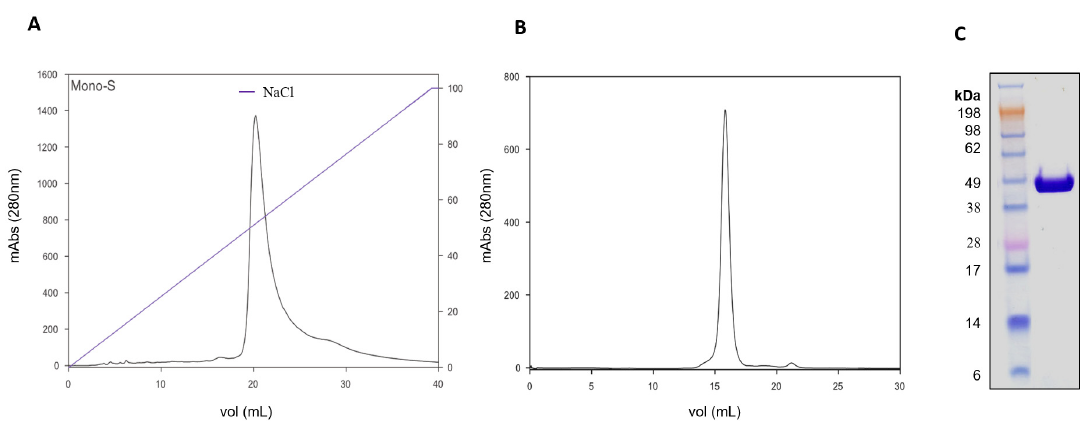
Figure 2. Purification of recombinant AlboD7L1. ( A ) Purification of AlboD7L1 by cation-exchange chromatography using a MonoS 5 / 50 GL column. Gradient of NaCl (%) is indicated by the blue line. ( B ) Purification of AlboD7L1 by size exclusion chromatography using a Superdex 200 Increase 10 / 300 GL column. ( C ) Coomassie-stained NuPAGE 4–12% Bis-Tris gel electrophoresis of recombinant protein AlboD7L1. SeeBlue Plus2 Pre-stained protein ladder was used as protein